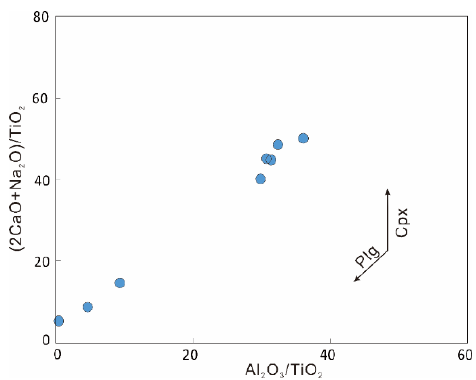
Figure 8. Variation diagrams of SiO 2 , TiO 2 , FeO T , CaO, P 2 O 5 , Cr, Ni, CaO/Al 2 O 3 , and Sc/Y versus Mg # for Yuejingshan gabbro samples.